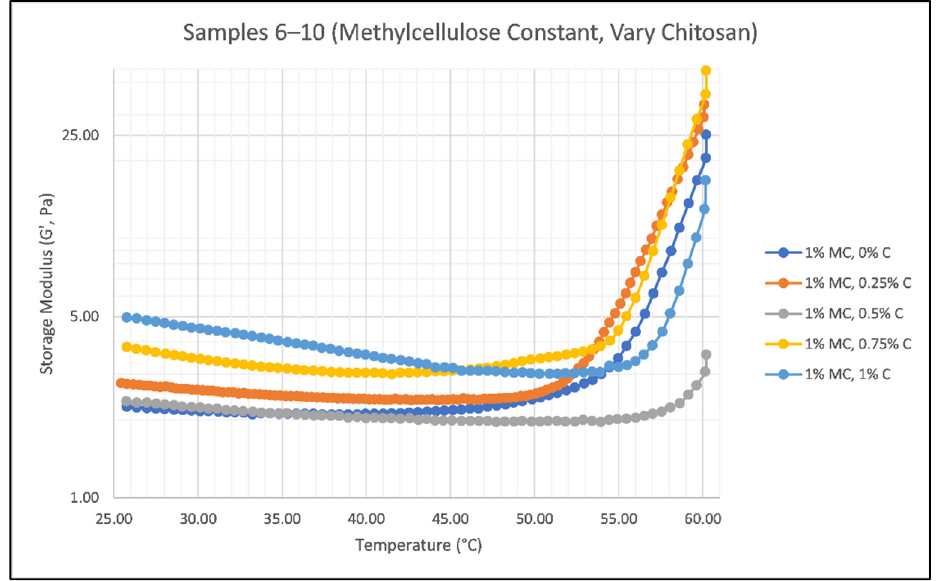
Figure 5. Effect of Chitosan Concentration on the Storage Modulus (G’) of Samples 6 (blue), 7 (orange), 8 (gray), 9 (yellow), and 10 (green) as temperature increases from 25 °C to 60 °C; where C is chitosan and MC is methylcellulose.